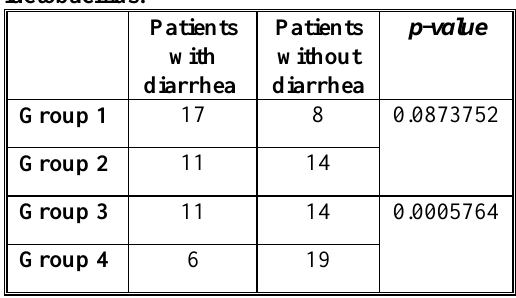
Table 2. Comparison in the incidence of diarrhea for patients after taking either ciprofloxacin or levofloxacin with patients taking ciprofloxacin and lactobacillus or levofloxacin and lactobacillus.